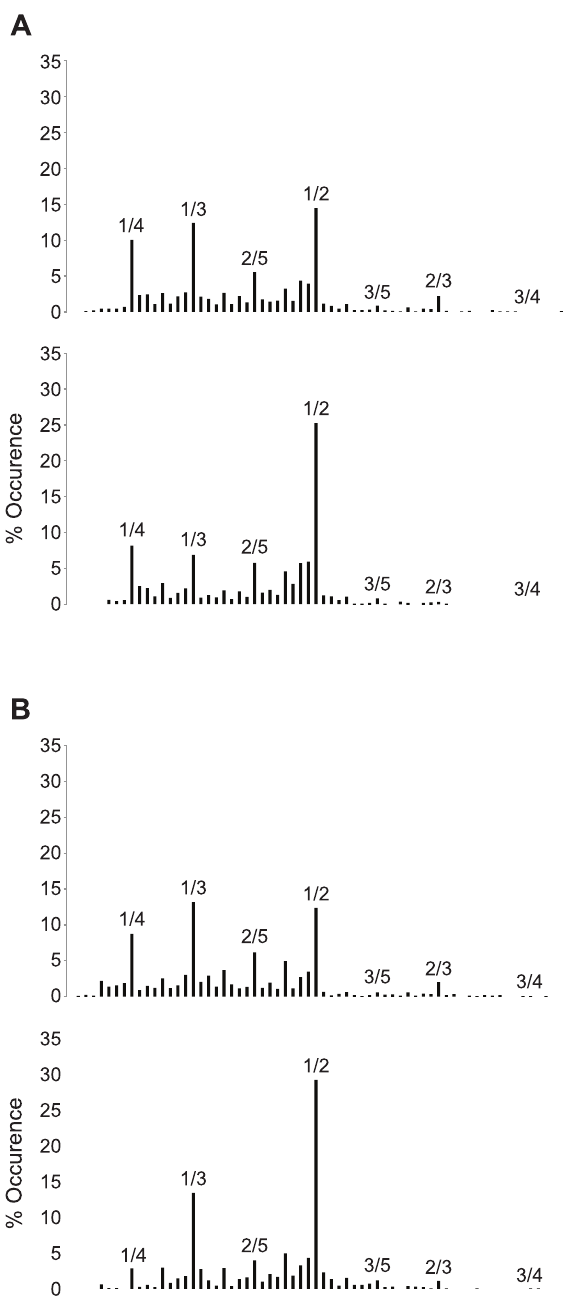
observed an asymmetry in the frequency ratios landscape (see Figure 6) resulting probably from the low-to-moderate exercise intensity imposed to participants. The energetic constraint of the task did not require higher respiratory frequencies in order to furnish the needed oxygen to the muscles. The increase of the load